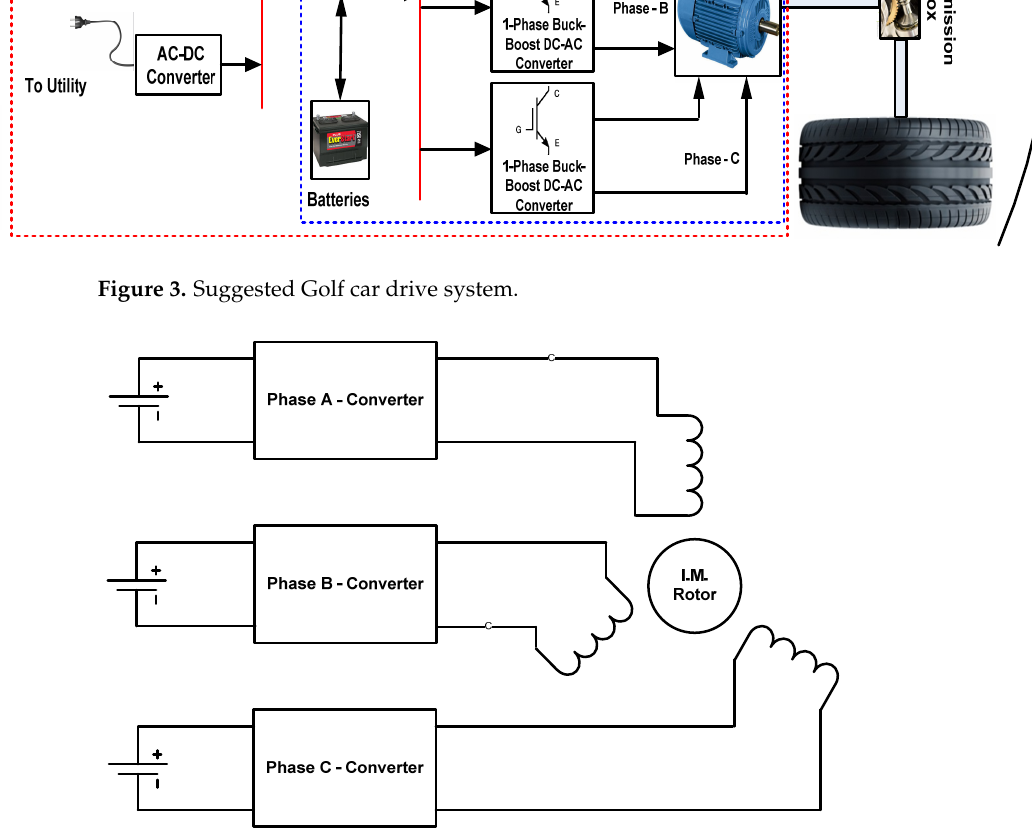
Figure 4. The Adopted Buck – Boost DC – AC Converter Feeding a 3-Phase Induction Motor.